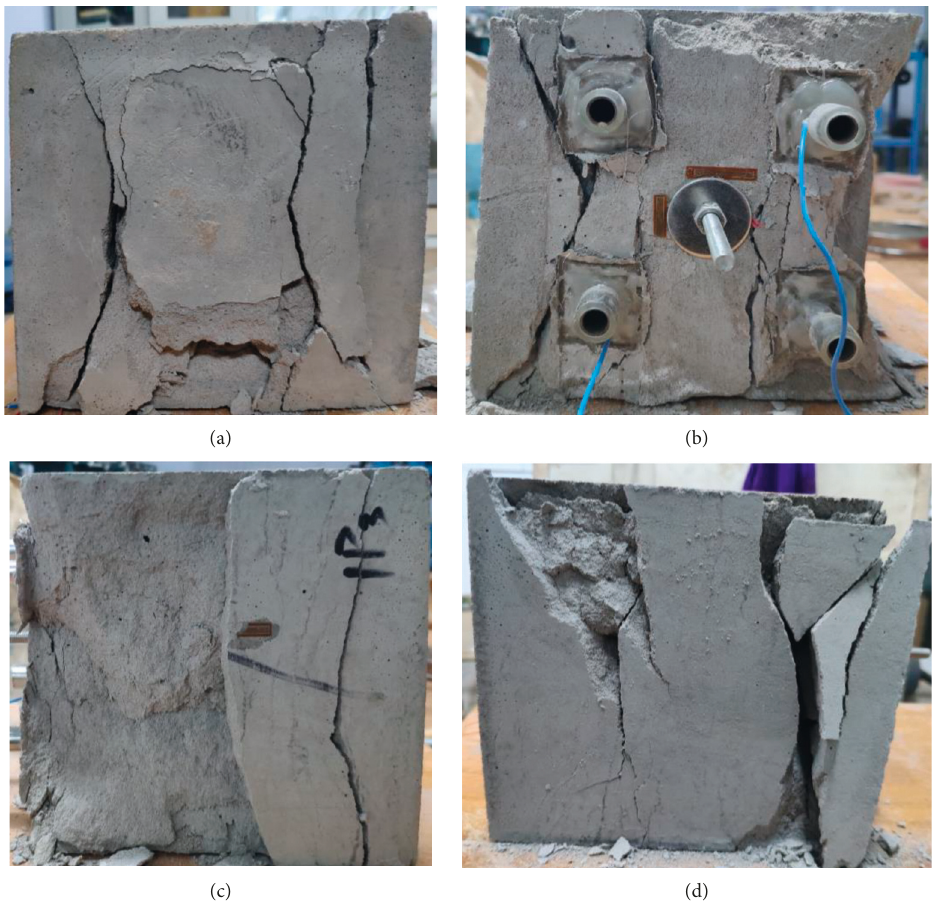
Figure 3: Failure characteristics of specimen GD. ((a) ∼ (d) are the four sides of test specimen